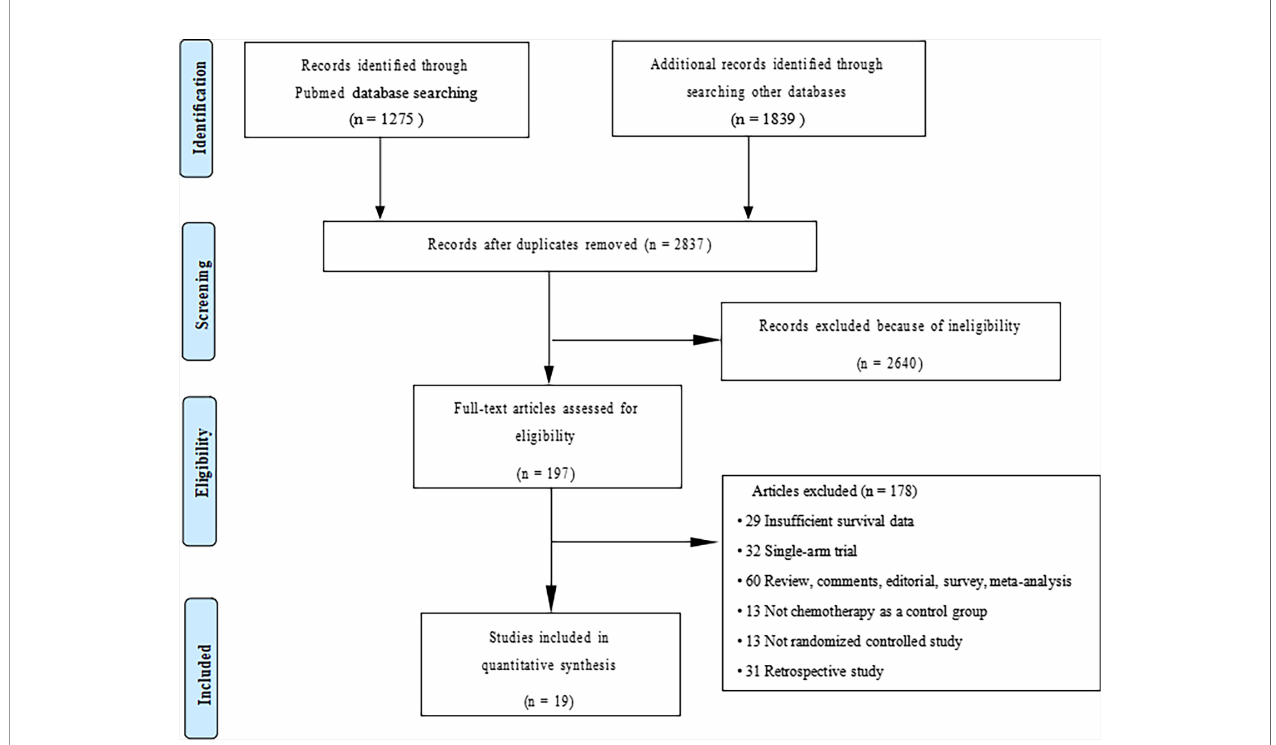
FIGURE 1 | Flowchart of study